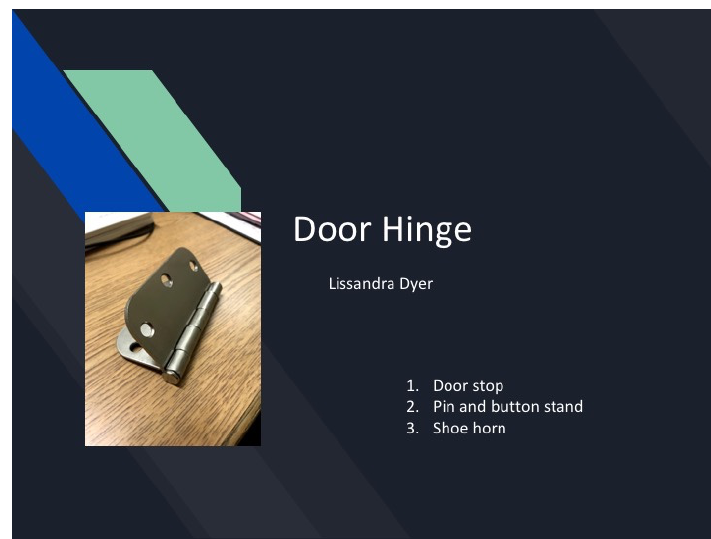
Figure 11. Repurposing Slide by Lissandra Hadron Dyer (2018).